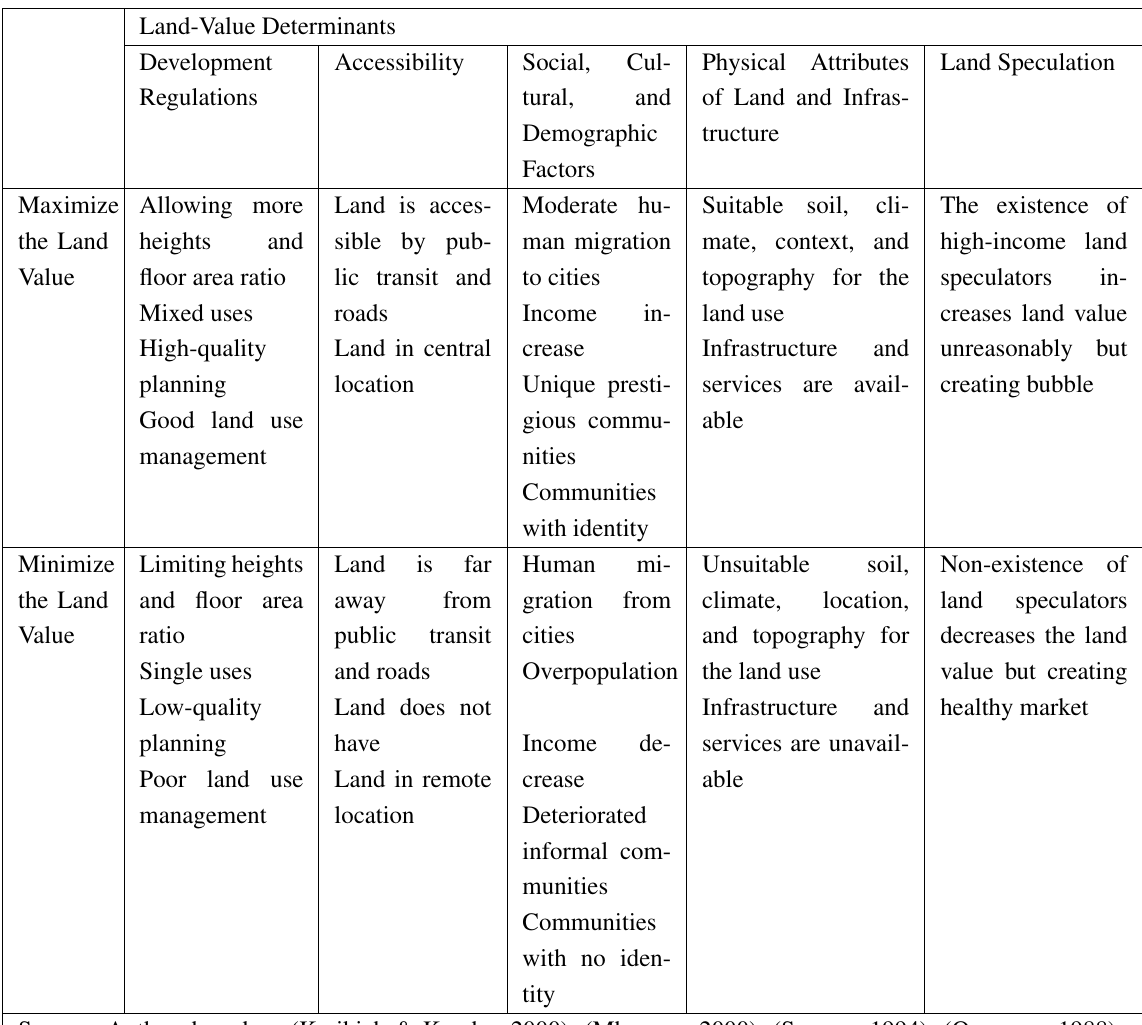
Table 2. Land Value Determinants